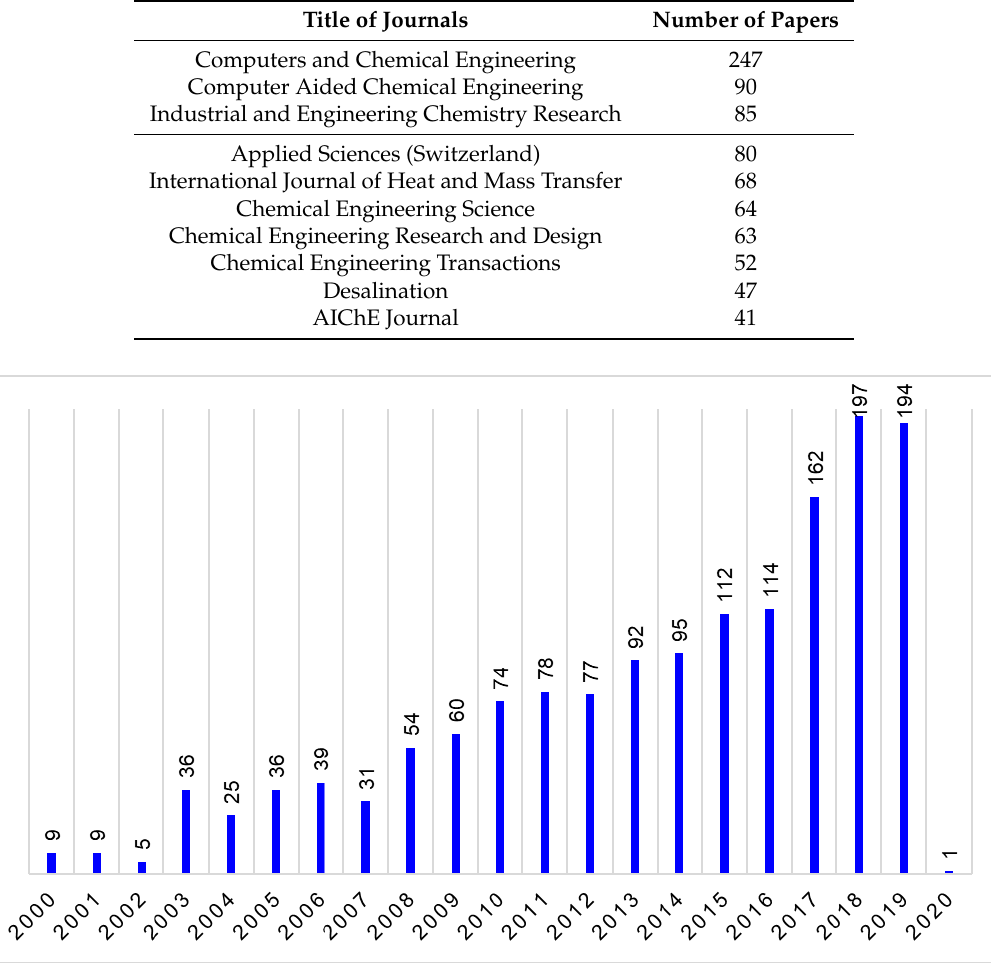
Figure 3. Number of journal papers containing multi / bi and objective and optimization / optimisation in the title, abstract, and keywords, from the year 2000 to the end of October 2019 in the journals related to CPE in the subject area of Chemical Engineering in Scopus. The number for the year 2019 is for 10 months only, and there is one paper for the year